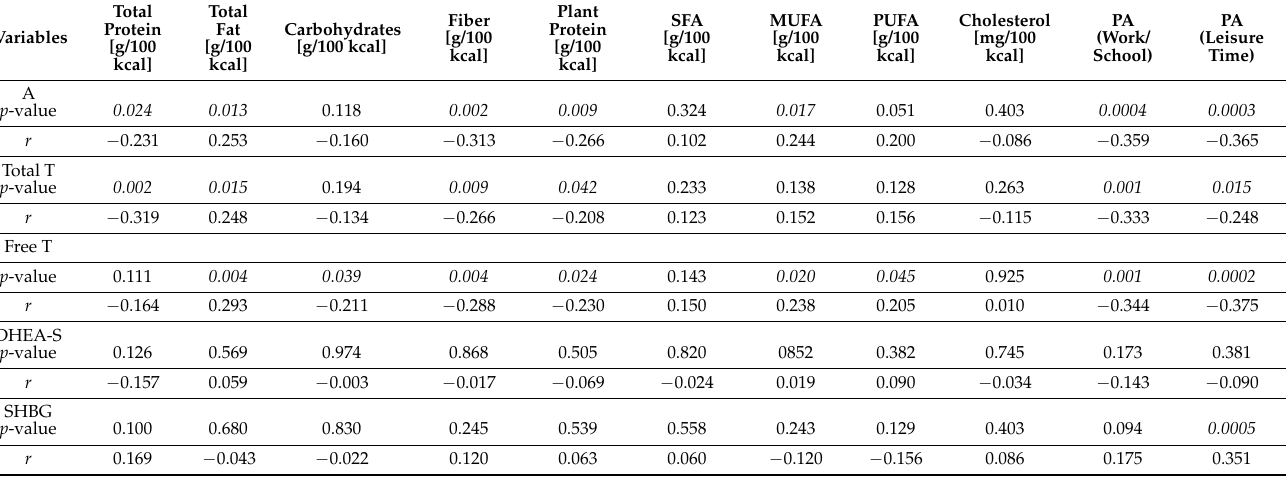
Table 2. Correlations among serum androgen level, and macronutrient intake adjusted for total